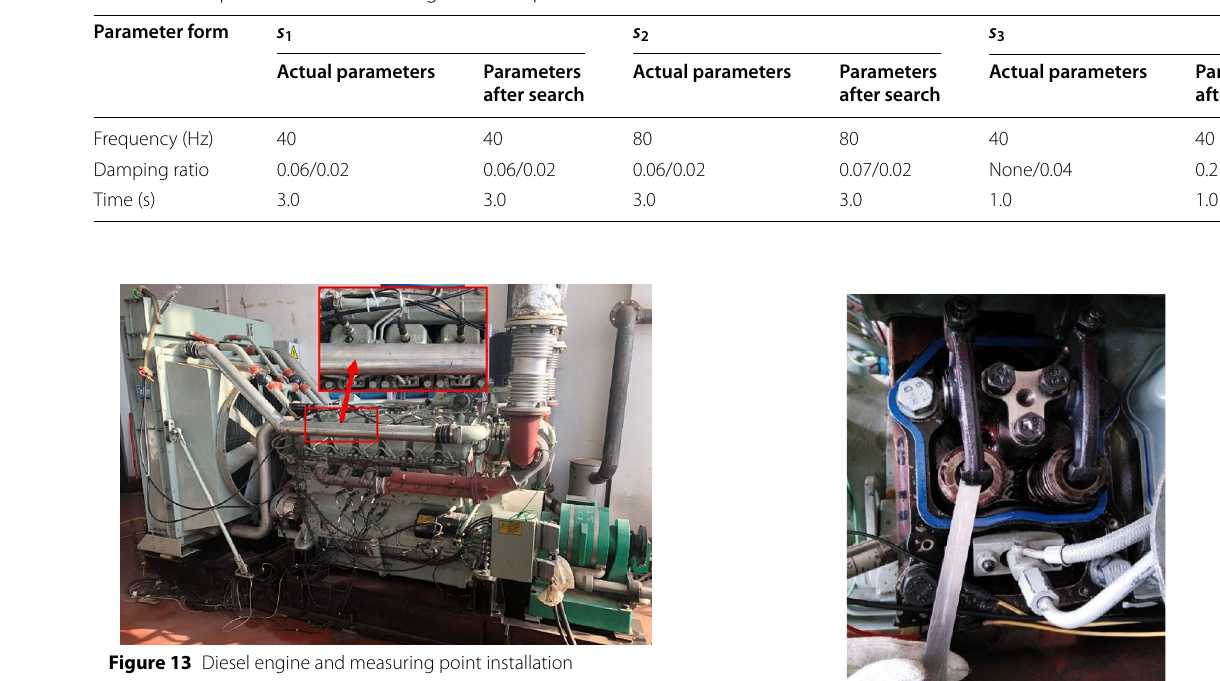
Table 3 Comparison of simulation signal search parameters